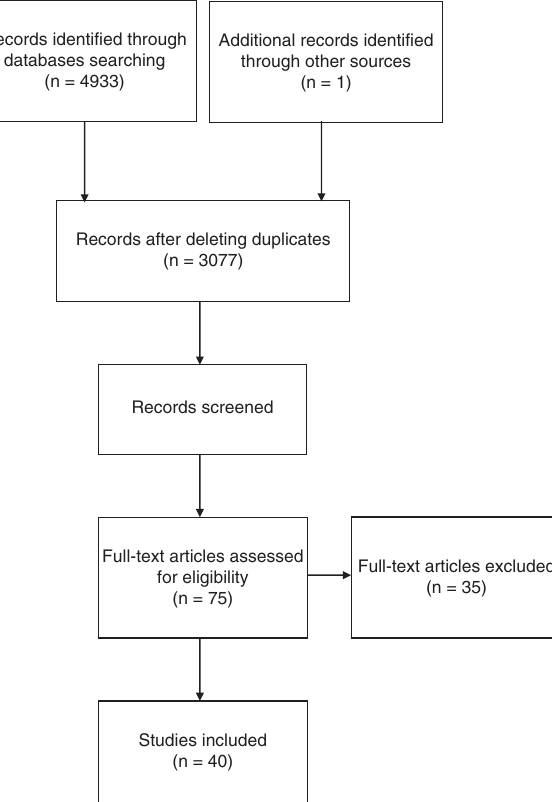
Figure 1: PRISMA Flowchart.